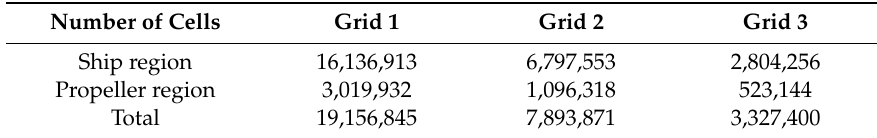
Table 4. The three systematic refined grids.